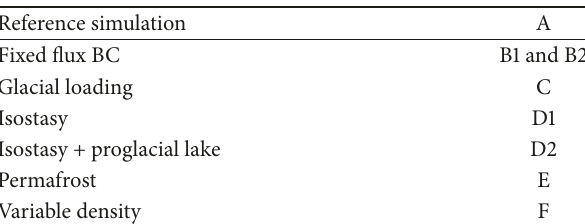
Table 1: List of simulations.